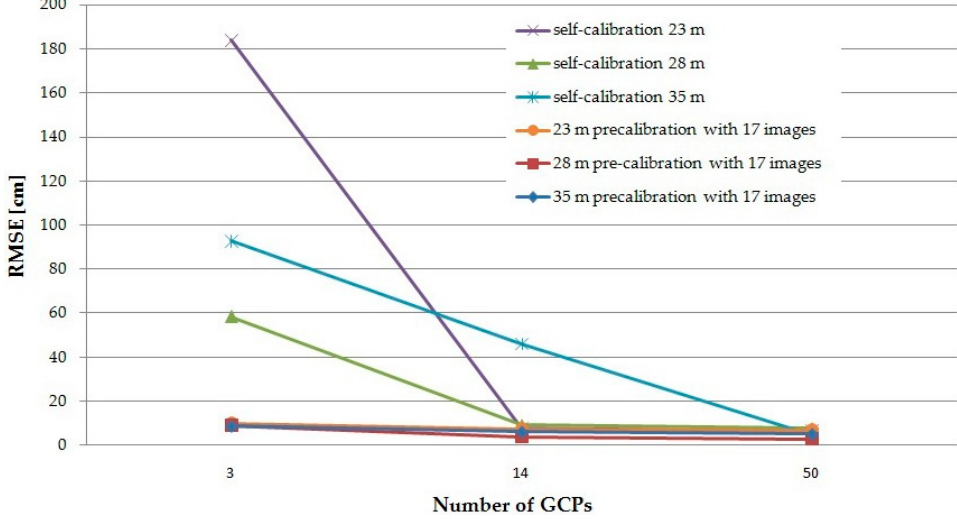
Figure 18. The RMSE resulted for the 23 m, 28 m, and 35 m flights when using self-calibration and pre-calibration with oblique images.